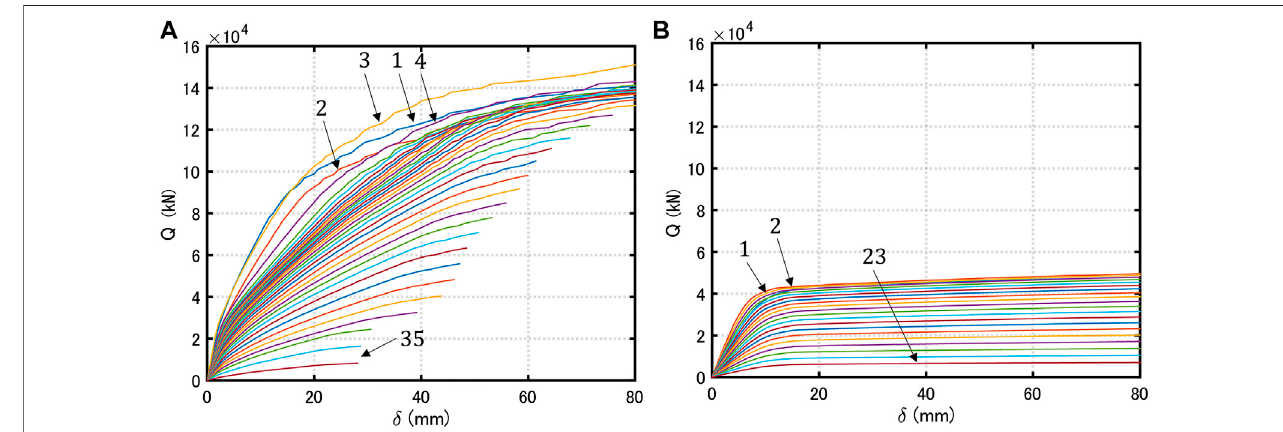
FIGURE 2 | Static pushover analysis (story shear vs interstory drift), (A) Main frame, (B) Sub frame (number in fi gure indicates story number).